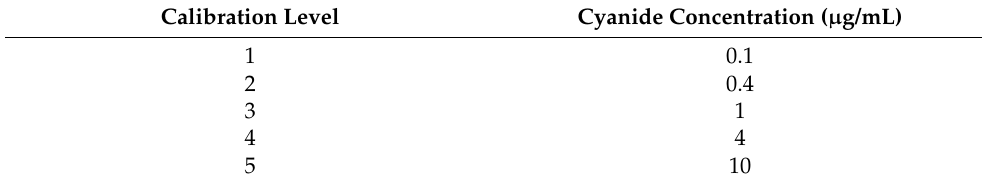
Table 1. PFB-CN calibration